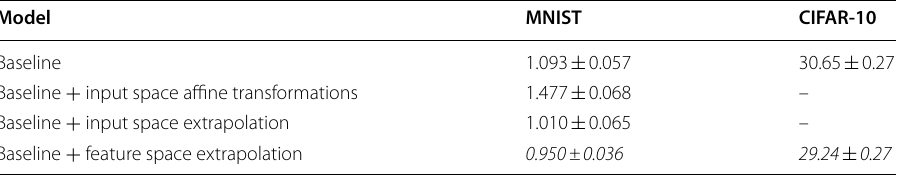
The italic value denote high performance according to the comparative